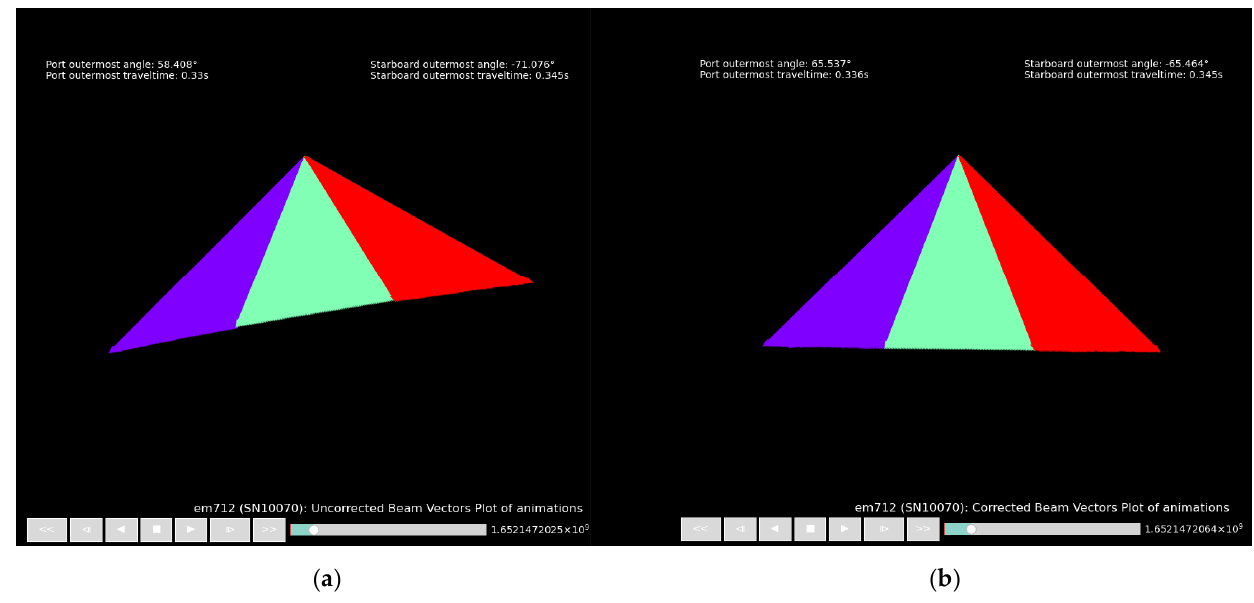
Figure 1 . Kluster animations of uncorrected and corrected beam vectors available in the Basic Plots tool. Illustrates: ( a ) Raw beam angles as seen in the multibeam data format and; ( b ) Raw angles corrected for attitude and mounting angles as a result of Kluster processing. Colored by multibeam sector.